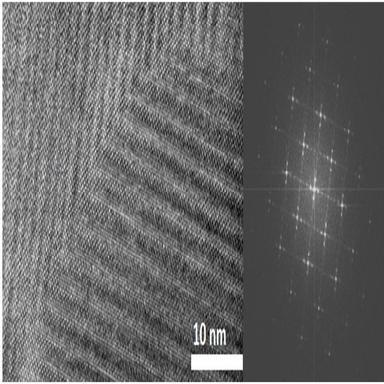
High Resolution TEM and STEM image taken from a 3:90:10 sample showing the incommensurate modulations (FFT inset).